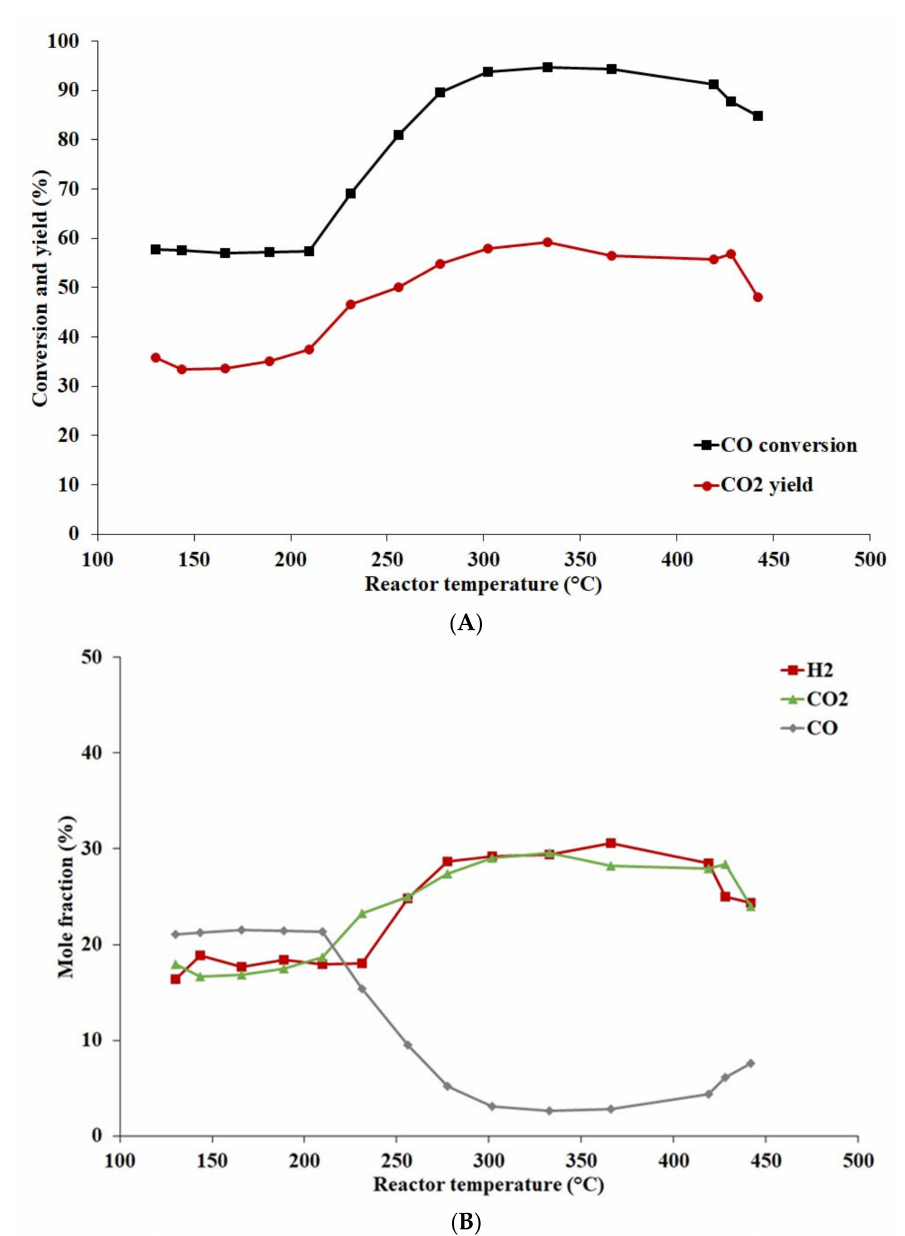
Figure 10. Catalytic tests with feed gas mixture 1 (50 mole% CO, 50 mole% N 2 ) at pressure 0.5 MPa over a Cu-based (11.4 wt%) catalyst prepared with non-calcined support: ( A )—CO conversion and CO 2 yield over an activated catalyst; ( B )—all product over an activated